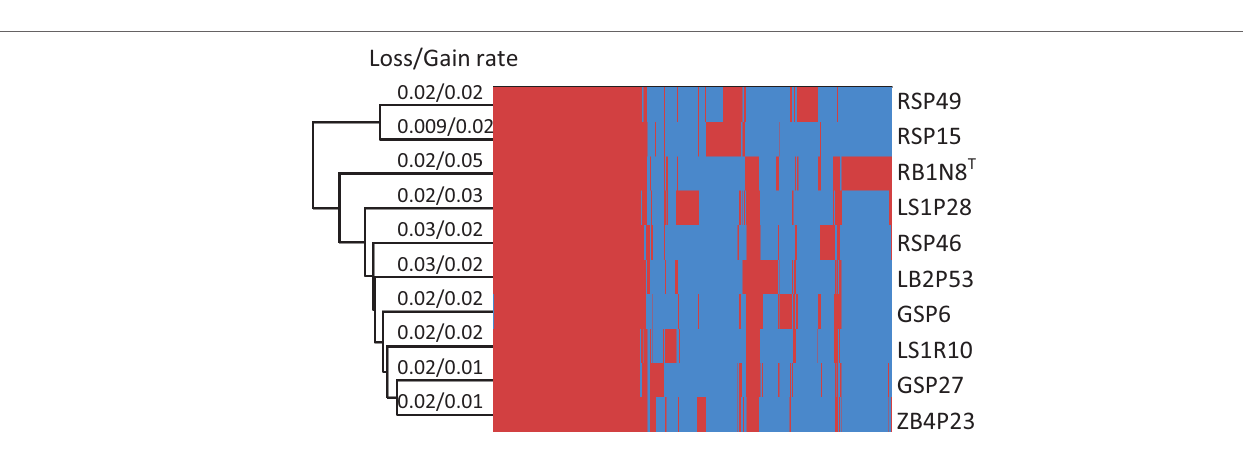
FIGURE 2 | COG distribution for the pan-genome of 10 glacier-inhabiting Flavobacterium strains determined using the BPGA tool with default parameters. The x axis represents the relative percentage of the number of genes in each functional